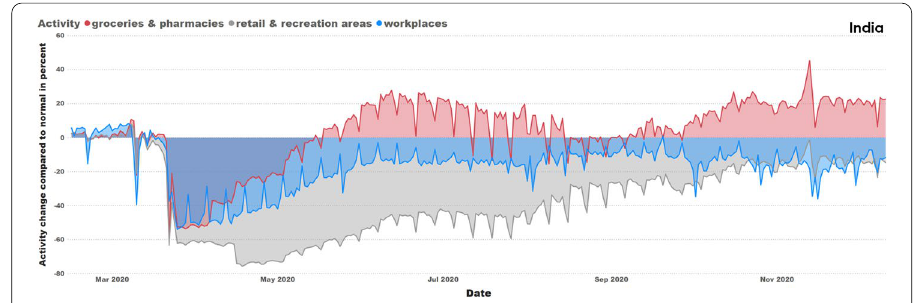
Fig. 16 Retail and Recreation type lockdown